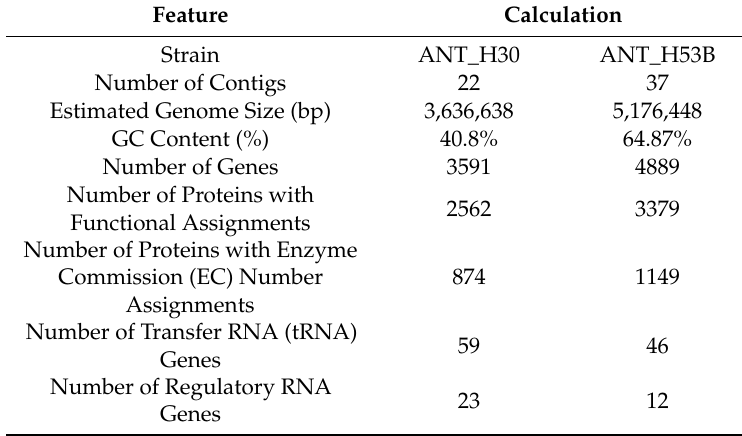
Table 1. General features of the Planococcus sp. ANT_H30 and Rhodococcus sp. ANT_H53B draft